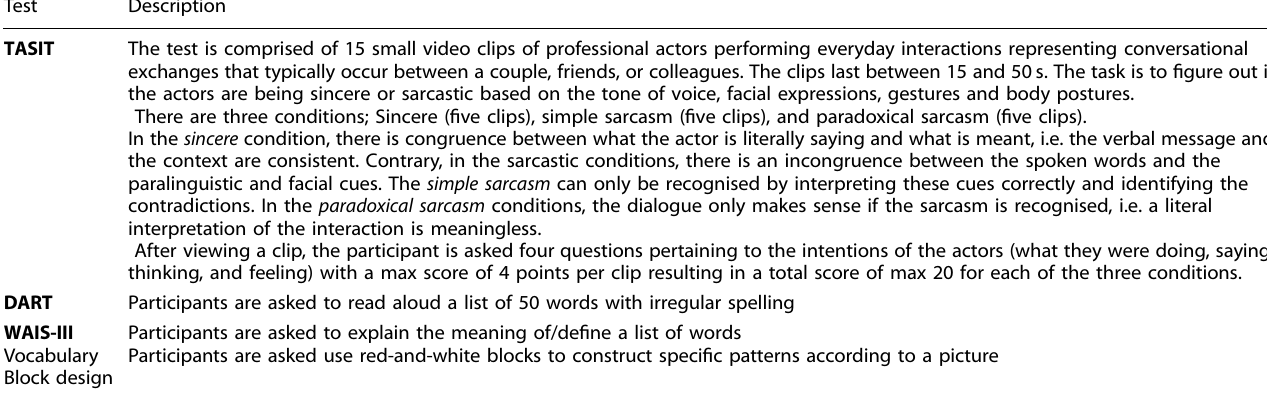
Table 2. Descriptions of the included cognitive